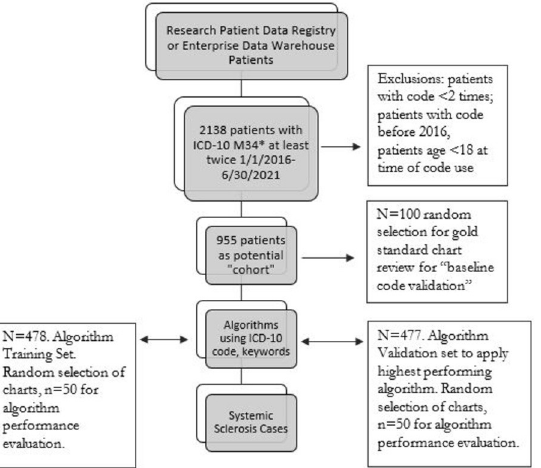
Fig 1. Cohort assembly. Overview of multi-stage process for SSc ICD-10 code validation and algorithm testing and validation. Patients were selected from healthsystem databases if the ICD-10 code was present at least twice in encounters, billing codes or the problem list. Of the 2138 potential patients 1183 were excluded and a random selection of 100 patients underwent code validation. The 955 patient cohort was divided in half for testing of two algorithms using disease manifestation keywords and internal validation of highest performing algorithm. When applied to the entire cohort, 788 patients were identified as likely cases. ICD-10 = International Classification of Diseases, Tenth